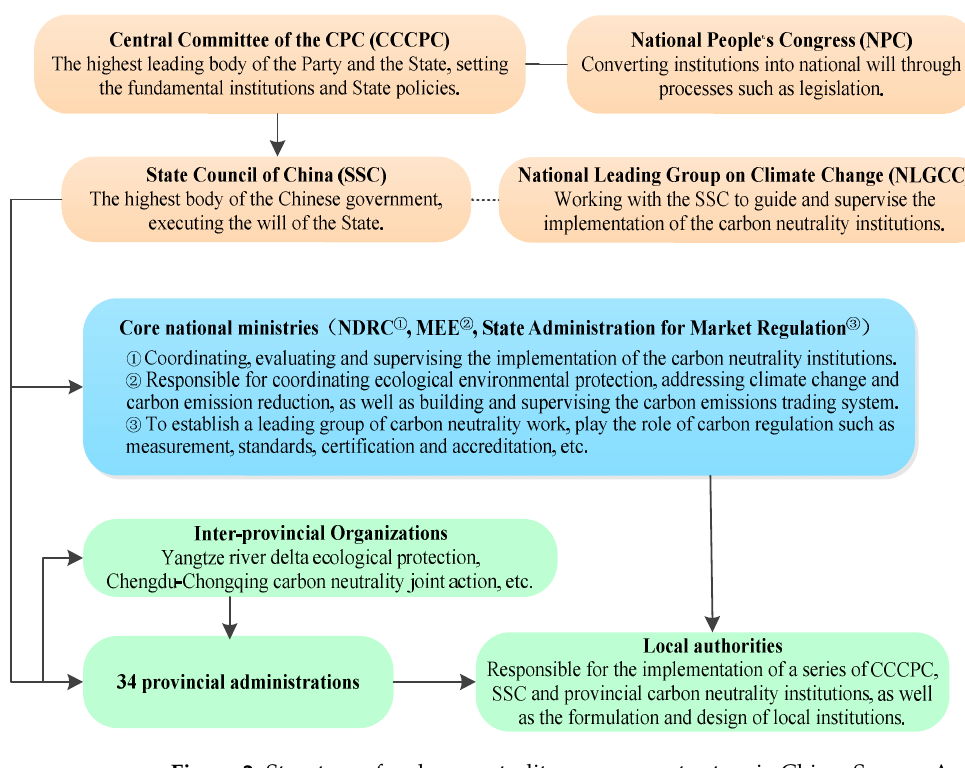
Figure 2. Structure of carbon neutrality government actors in China. Source: Authors’ compilation.